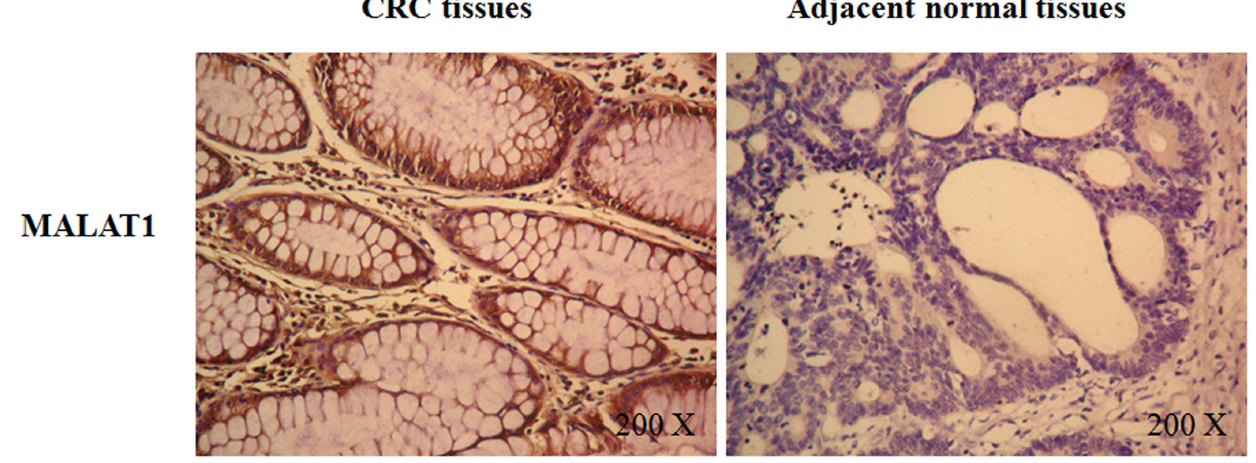
Figure 1. Overexpression of MALAT1 in human colorectal cancer tissues. In situ hybridization was applied to investigate the MALAT1 expression in 60 paraffin-embedded tumor tissue and adjacent normal tissue samples of CRC patients.